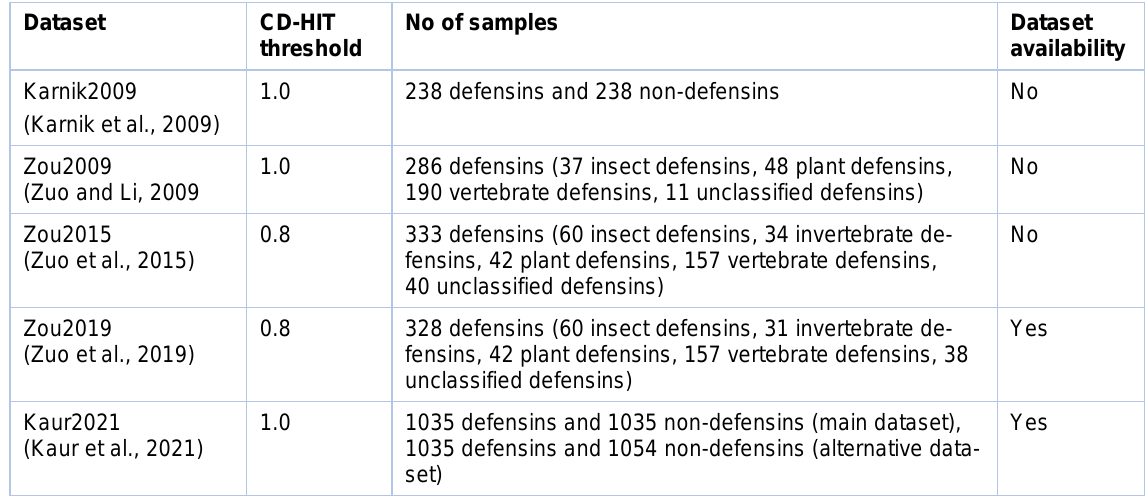
Table 2: The detailed information of the existing datasets used for analyzing in this